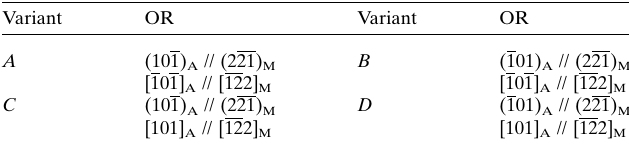
Table 4 OR between the original austenite and the four martensite variants A , B , C and D shown in Fig. 2( a ).